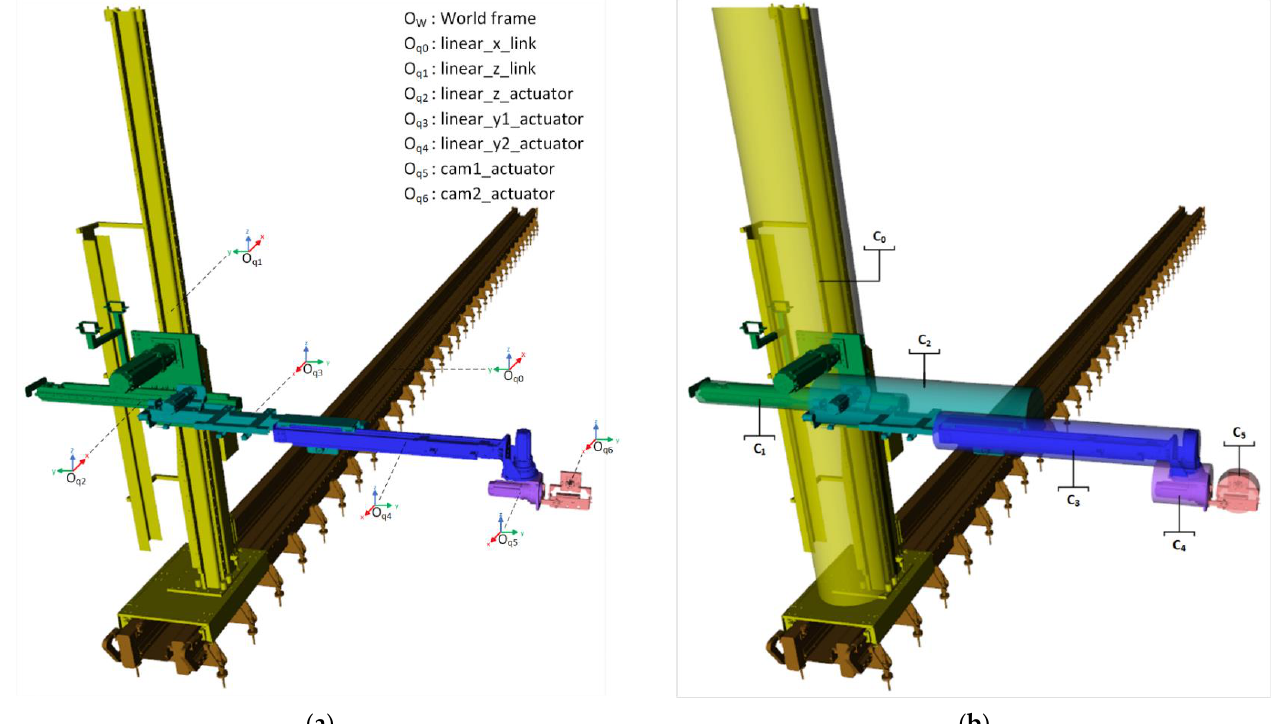
Figure 7. The robot frames and cylinder representations for ROKOS: ( a ) robot frames, ( b ) cylinders.